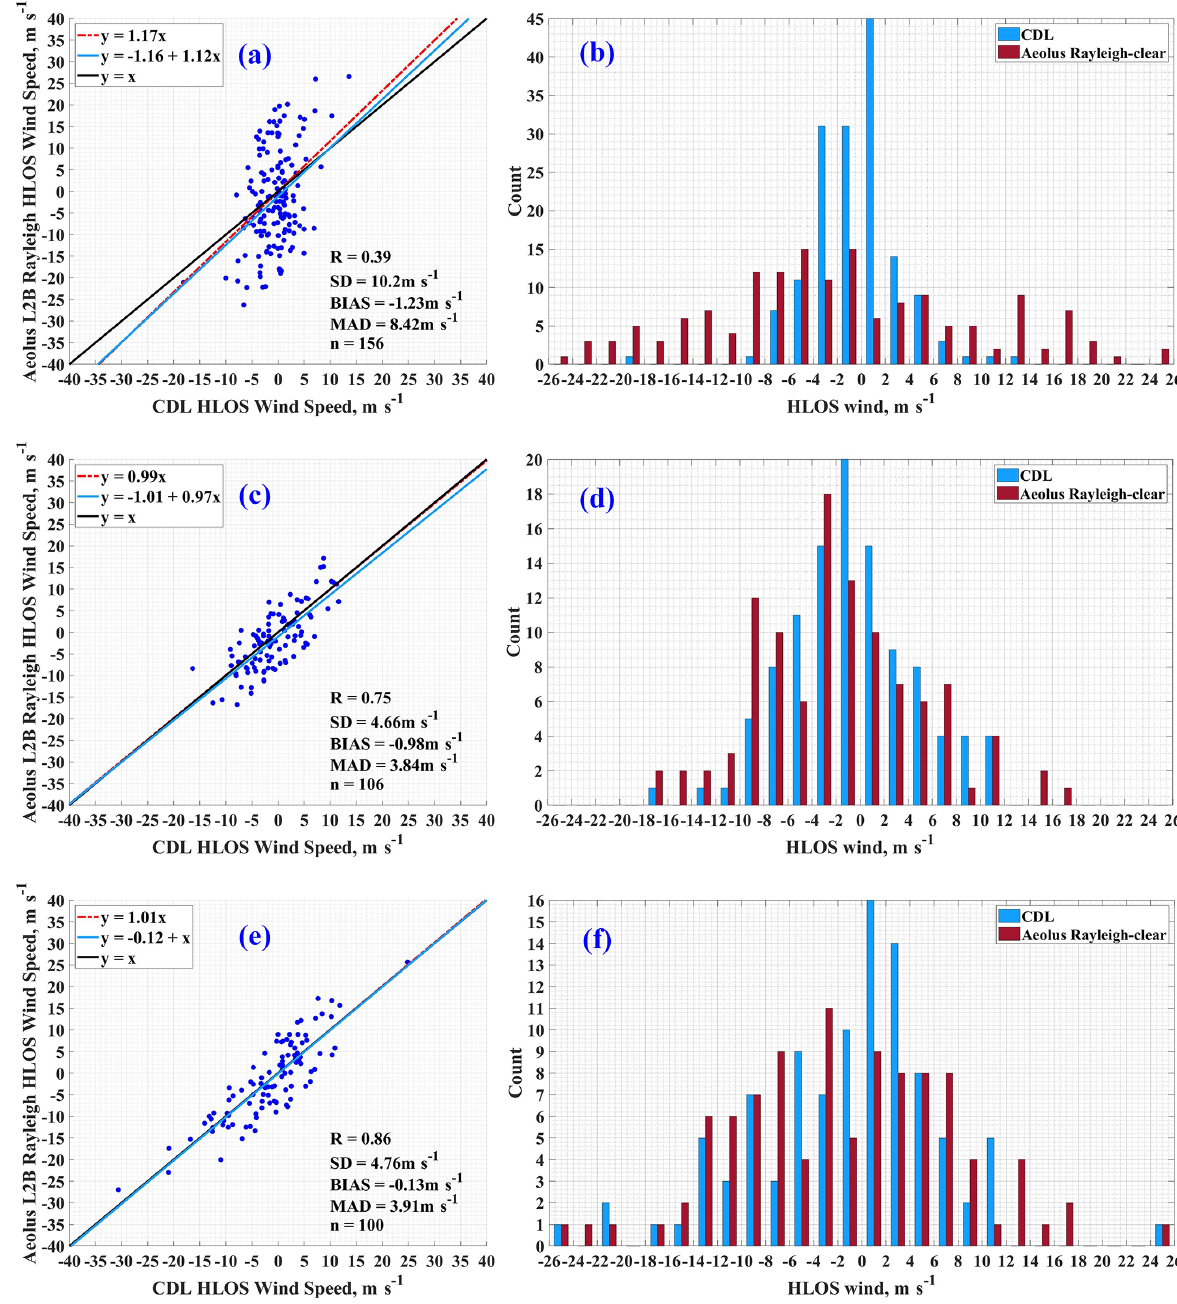
Figure 12. The comparison between the Aeolus L2B Rayleigh HLOS wind data from (a, b) Baselines 07 and 08, (c, d) Baselines 09 and 10, and (e, f) Baseline 11 against the CDL-retrieved HLOS wind data. The lines and the histograms represent the same as those of Fig.